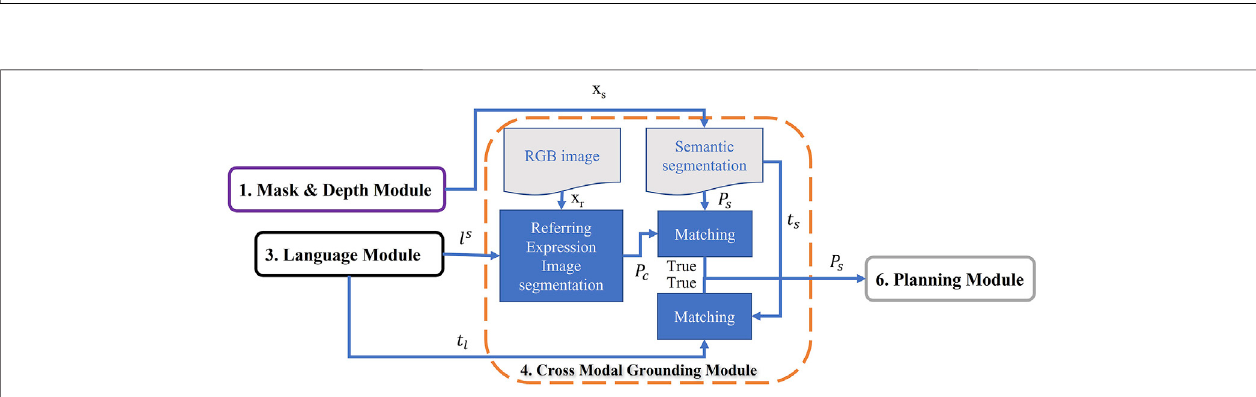
FIGURE9| Cross-ModalGroundingModule:Thismoduledetectsthepixelsofobjectofinterestextractedfromlanguageinstructionusingavisionlanguagemodel (U-NET). The output of this module is further used for manipulation and navigation in Planning Module.